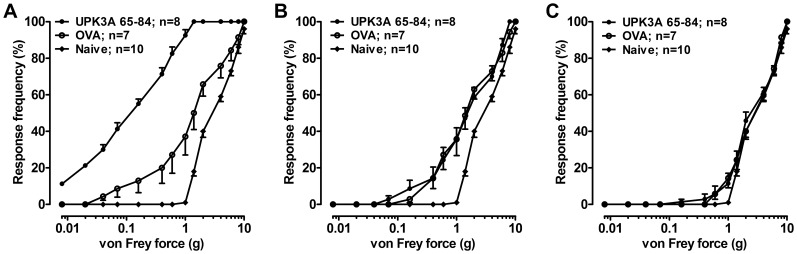
Adoptive transfer of EAC pelvic pain.Pelvic pain was assessed by application of von Frey filaments to the suprapubic pelvic region of female BALB/c mice 10 days after adoptive transfer of 10-day immunogen-primed and -activated CD4+ or CD8+ T cells, or serum. (A) UPK3A 65-84-induced CD4+ T cells yielded increased responses to stimulation compared with CD4+ T cells from OVA-immunized and uninjected naïve mice (p<0.01 and p<0.0001, respectively, by one way ANOVA of log-transformed 50% thresholds with Tukey’s multiple comparison test). In the same analysis, the 50% thresholds of OVA-immunized and naïve mice also differed significantly from each other (p<0.01) (B) UPK3A 65-84-induced CD8+ T cells yielded similar responses to stimulation of the suprapubic region compared with OVA-induced CD8+ T cells, though both were more sensitive to stimulation than uninjected naïve mice (p<0.01 in each case). (C) Serum samples collected 5 weeks after immunization of mice with UPK3A 65–84 or OVA were transferred into naïve female BALB/c recipients by 3 i.v. injections of 200 µl serum per mouse. Application of von Frey filaments 10 days later revealed no significant differences in responses among uninjected naïve mice and recipients of serum from UPK3A 65–84- or OVA immunized mice. Error bars indicate plus and minus SEM.